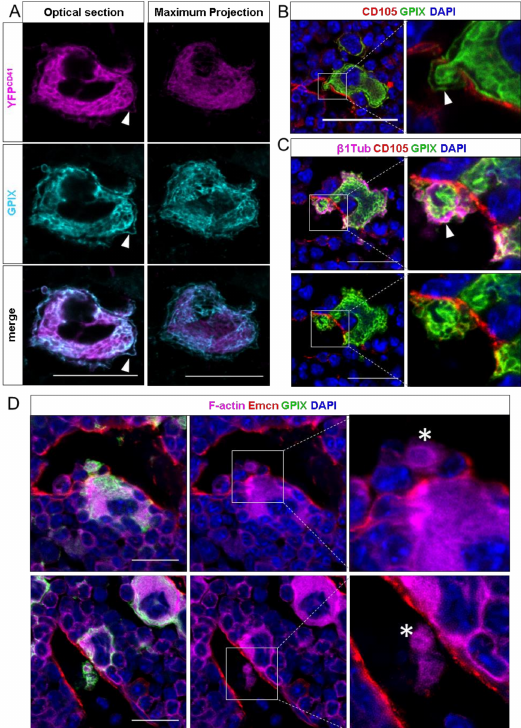
Figure 1. Confocal images of murine femur sections. ( A ) CD41 wt/eYFP MKs were co-stained with GPIX. Optical sections show a strong signal overlap for the DMS, but less for the plasma membrane. In maximum projections, the plasma membrane staining becomes less visible. ( B ) Detection of intravasating megakaryocytes by immunohistochemical staining against GPIX and the endothelial marker endoglin (CD105). MKs enter the sinusoidal lumen as large protrusions and maintain a marginal zone (MZ) while crossing the endothelial lining. ( C ) Co-staining of vessels with GPIX and β 1 -tubulin. The MK-specific microtubule isoforms fill the MZ, while protruding the endothelial lining of the sinusoid. ( D ) Visualization of the F-actin cytoskeleton with sinusoids, stained by an additional vessel-marker endomucin (Emcn) and MKs. Large MK protrusions in the vessel lumen are highly actin-enriched, displaying the involvement of the actin-cytoskeleton in the transendothelial passage of MK protrusions. White arrows indicate the MZ, actin-rich proplatelets are marked with asteriscs. Scale bars 20 µ